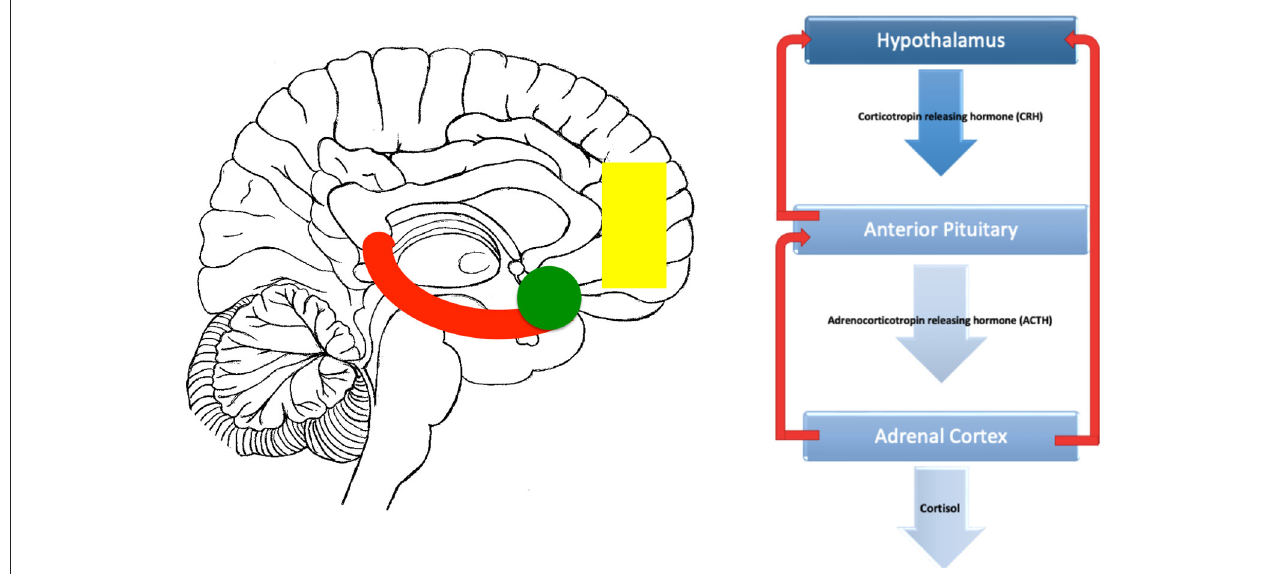
FIGURE 1 | Brain related areas and the HPA axis. On the left is a midline saggital representation of the brain showing a stylised hippocampus (red), amygdala (green) and medial prefrontal cortex (yellow). On the right, the classic HPA axis is shown. Inputs to the HPA from the hippocampus are mostly inhibitory, inputs from the amygdala are mostly excitatory while the prefrontal inputs can be both inhibitory and excitatory depending on whether they originate from the dorsal (inhibitory) or vental (excitatory) prefrontal